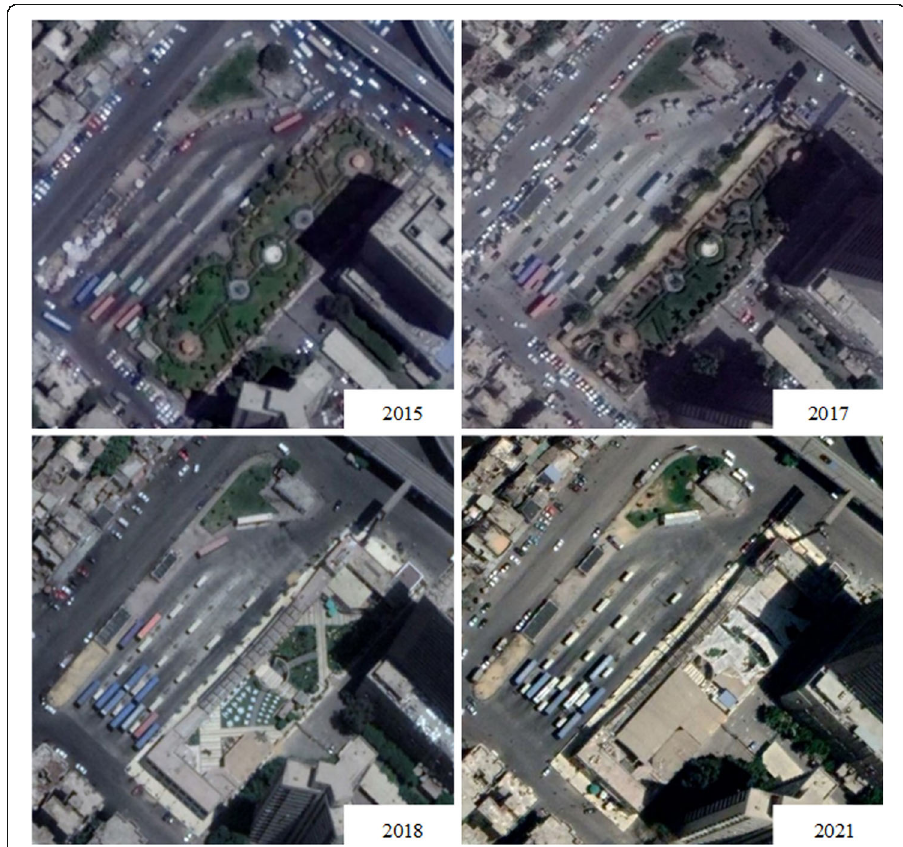
Fig. 8 Change in a green space at al-Abbasiya Square, al-Waily District, Map data © 2021